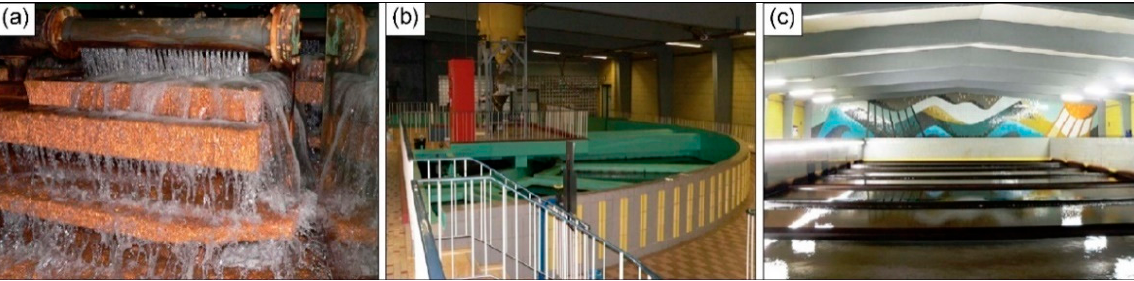
Figure 2. Aeration chamber ( a ), accelerator ( b ), and filter hall ( c ) in the Fuhrberg waterworks.